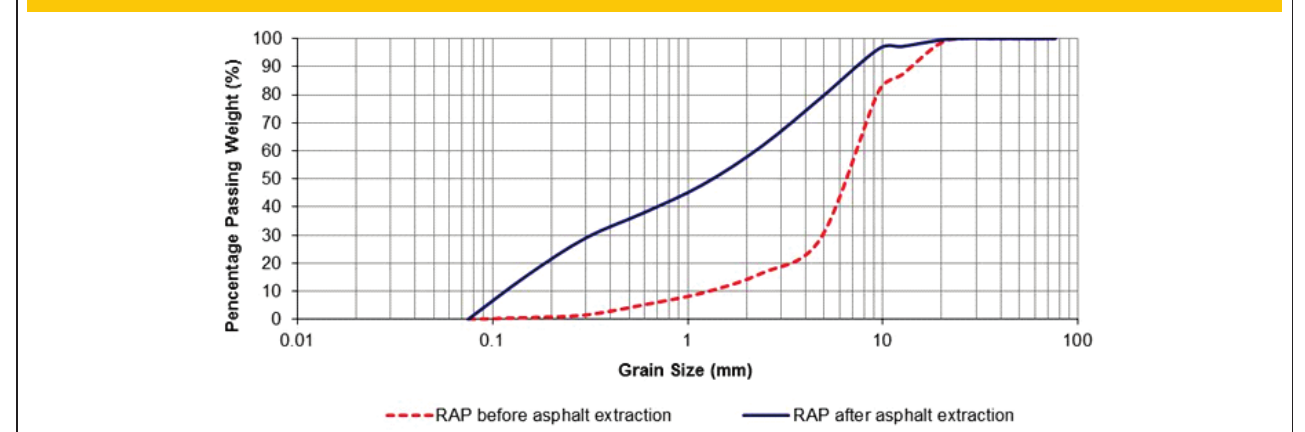
Figure 2 – Particle size distributions before and after extraction of the surrounding asphalt